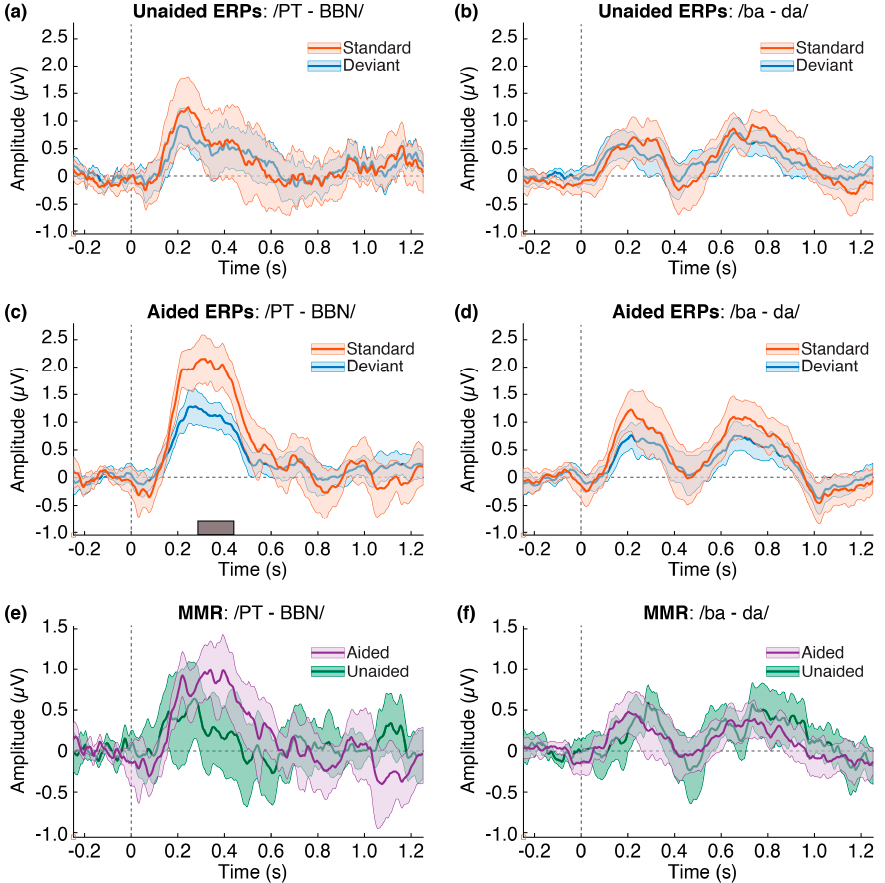
Figure 3. Grand averaged ERP responses (a–d) and MMR (e,f) for each contrast and listening condition. In each panel, time (seconds), is represented on the abscissa with stimulus onset at time = 0 and relative amplitude (microvolts) is represented on the ordinate. Solid lines in each waveform represent the group averaged mean response and shaded regions represent the 95% confidence intervals for 10,009 bootstrapped permutations of the subject responses.